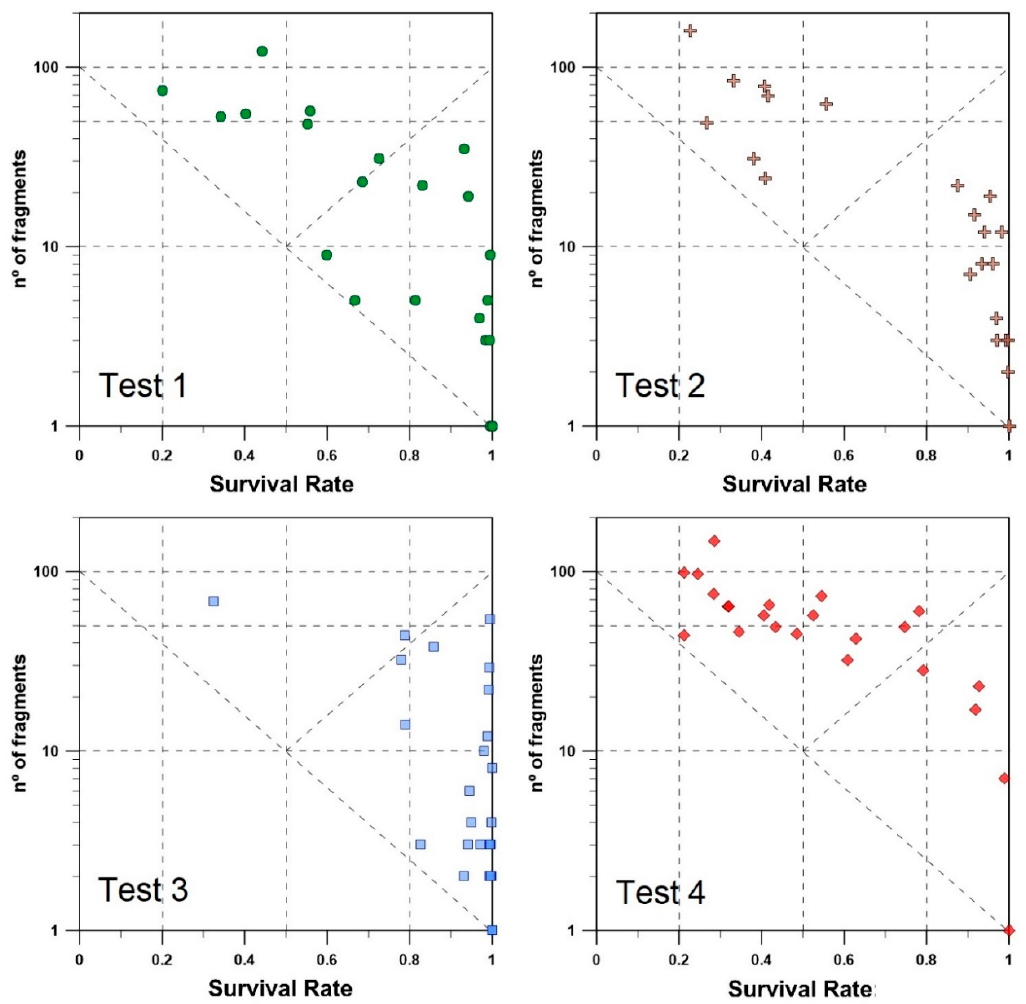
Figure 18. Survival rate versus number of fragments produced for each tested block, in each test site.